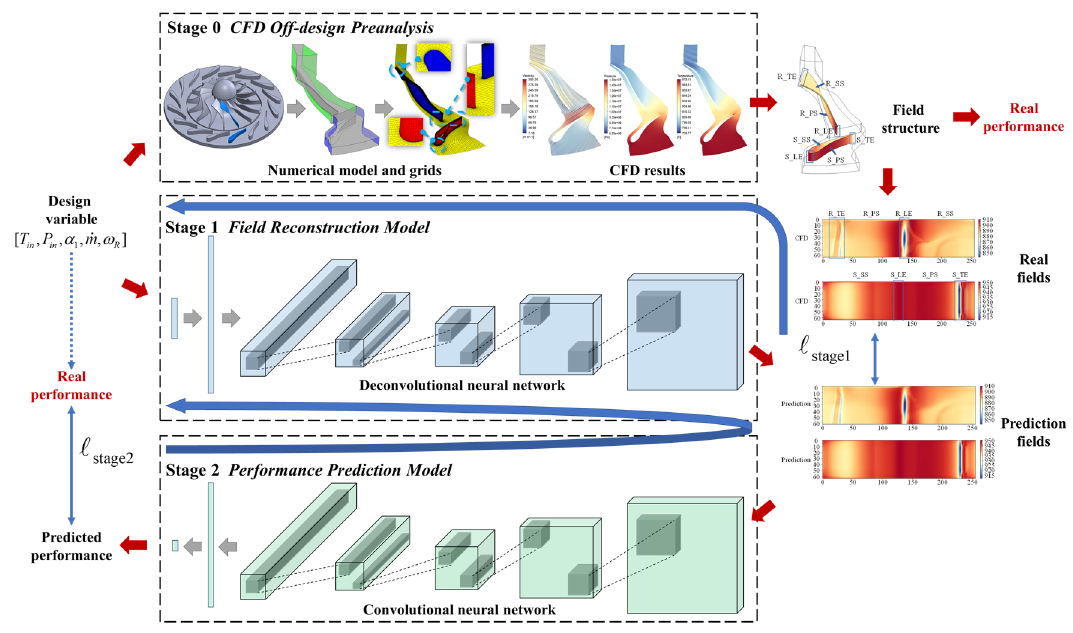
Figure 1. The overall architecture.